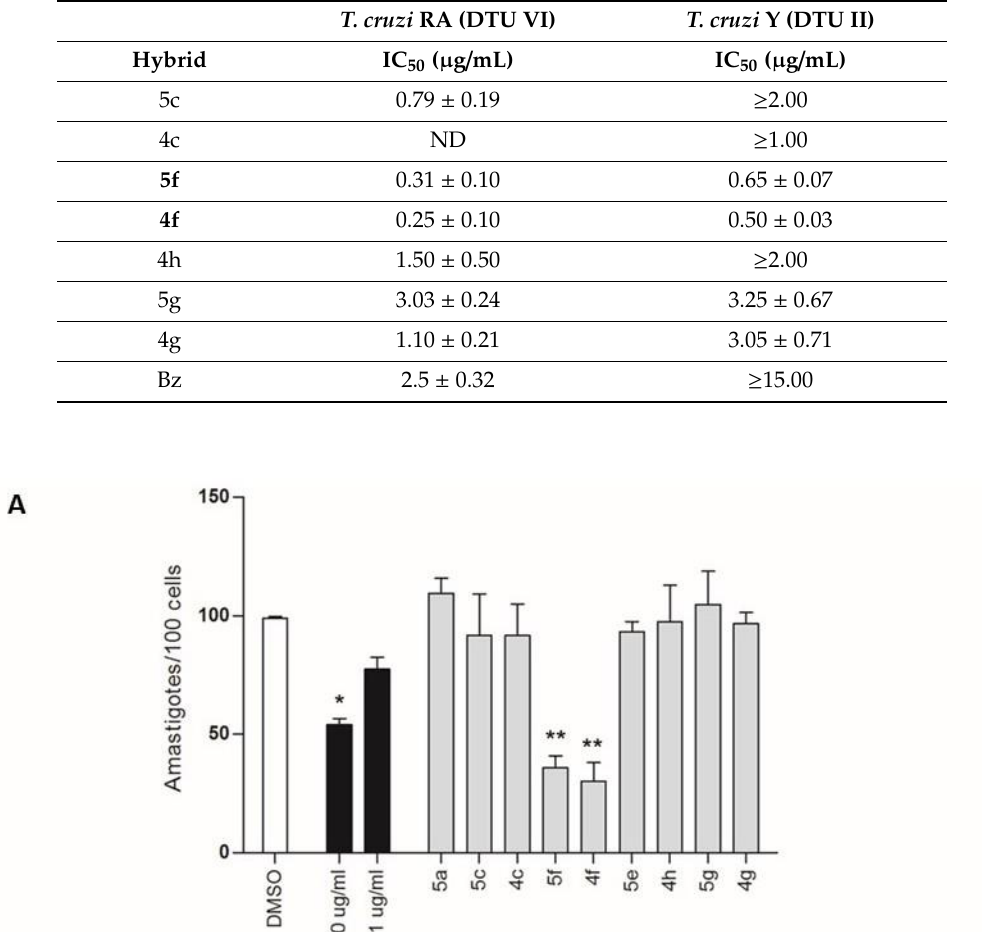
Table 3. Hybrid IC 50 values for T. cruzi tripomastigote strains from di ff erent discrete typing units (DTUs).